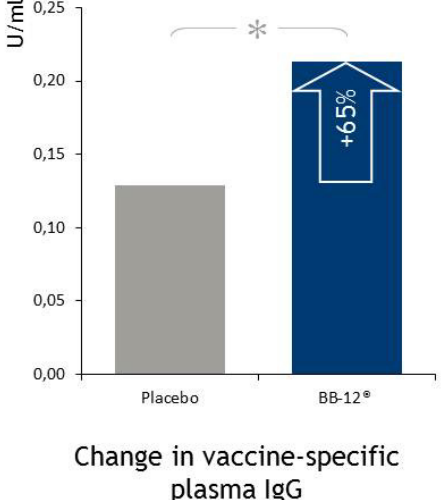
Figure 4. In a randomized, double-blind, placebo-controlled study by Rizzardini et al . 2012 [40], BB-12 ® was shown to improve immune function. Reproduced from Rizzardini et al . 2012 [40] with permission of Cambridge University Press, Copyright 2012.